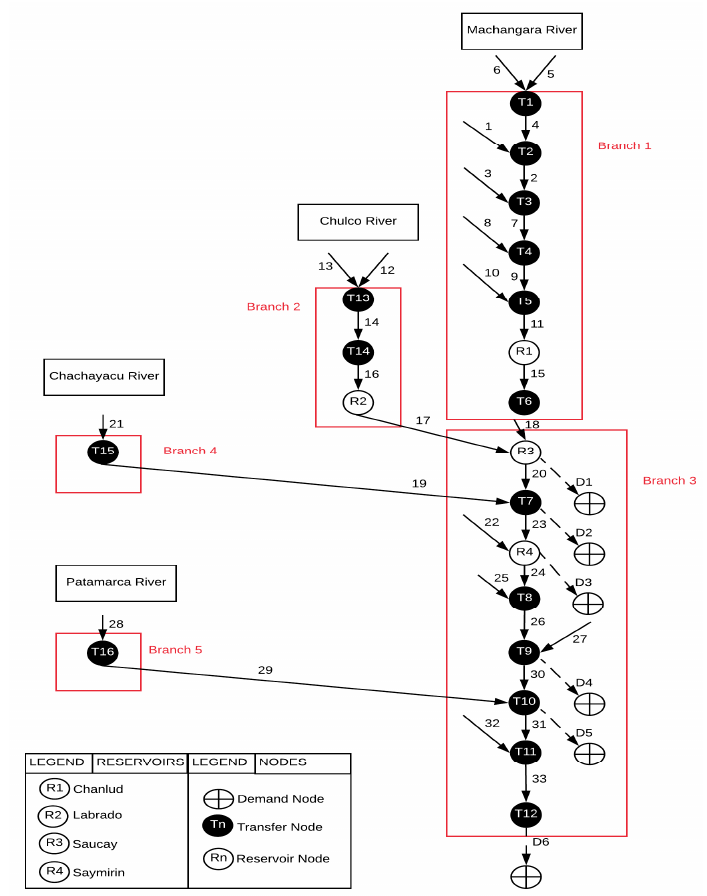
Figure 10. River network branches used for calibration of the parameters of the LP-model. Table 5. Parameters per segment during the final